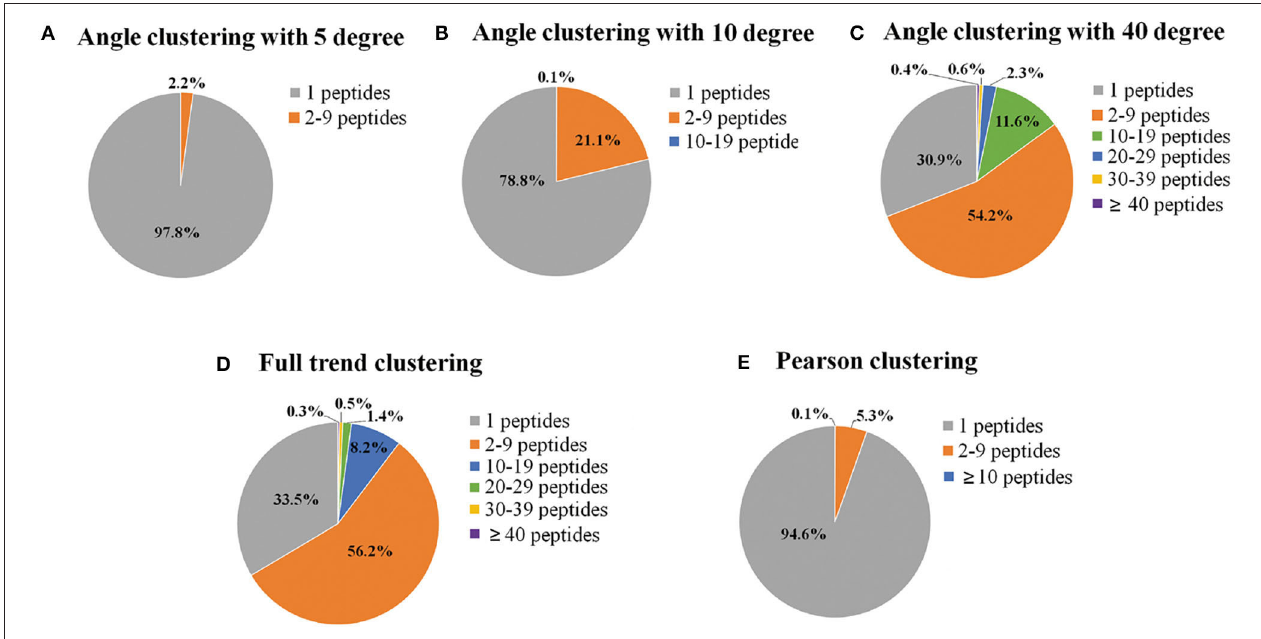
FIGURE 3 | Pie charts of the percentages of clusters containing different numbers of phosphopeptides. The original time-series data of the relative expression levels of phosphorylated peptides were clustered, and then the percentage of the clusters containing different numbers of phosphopeptides was calculated by different clustering methods, including angle clustering at 5 ◦ (A) , 10 ◦ (B) , and 40 ◦ (C) , full trend clustering (D) , and Pearson clustering (E) . Full trend clustering: considering only the direction and not the extent of the changes. Pearson clustering: clustering based on Pearson’s correlation